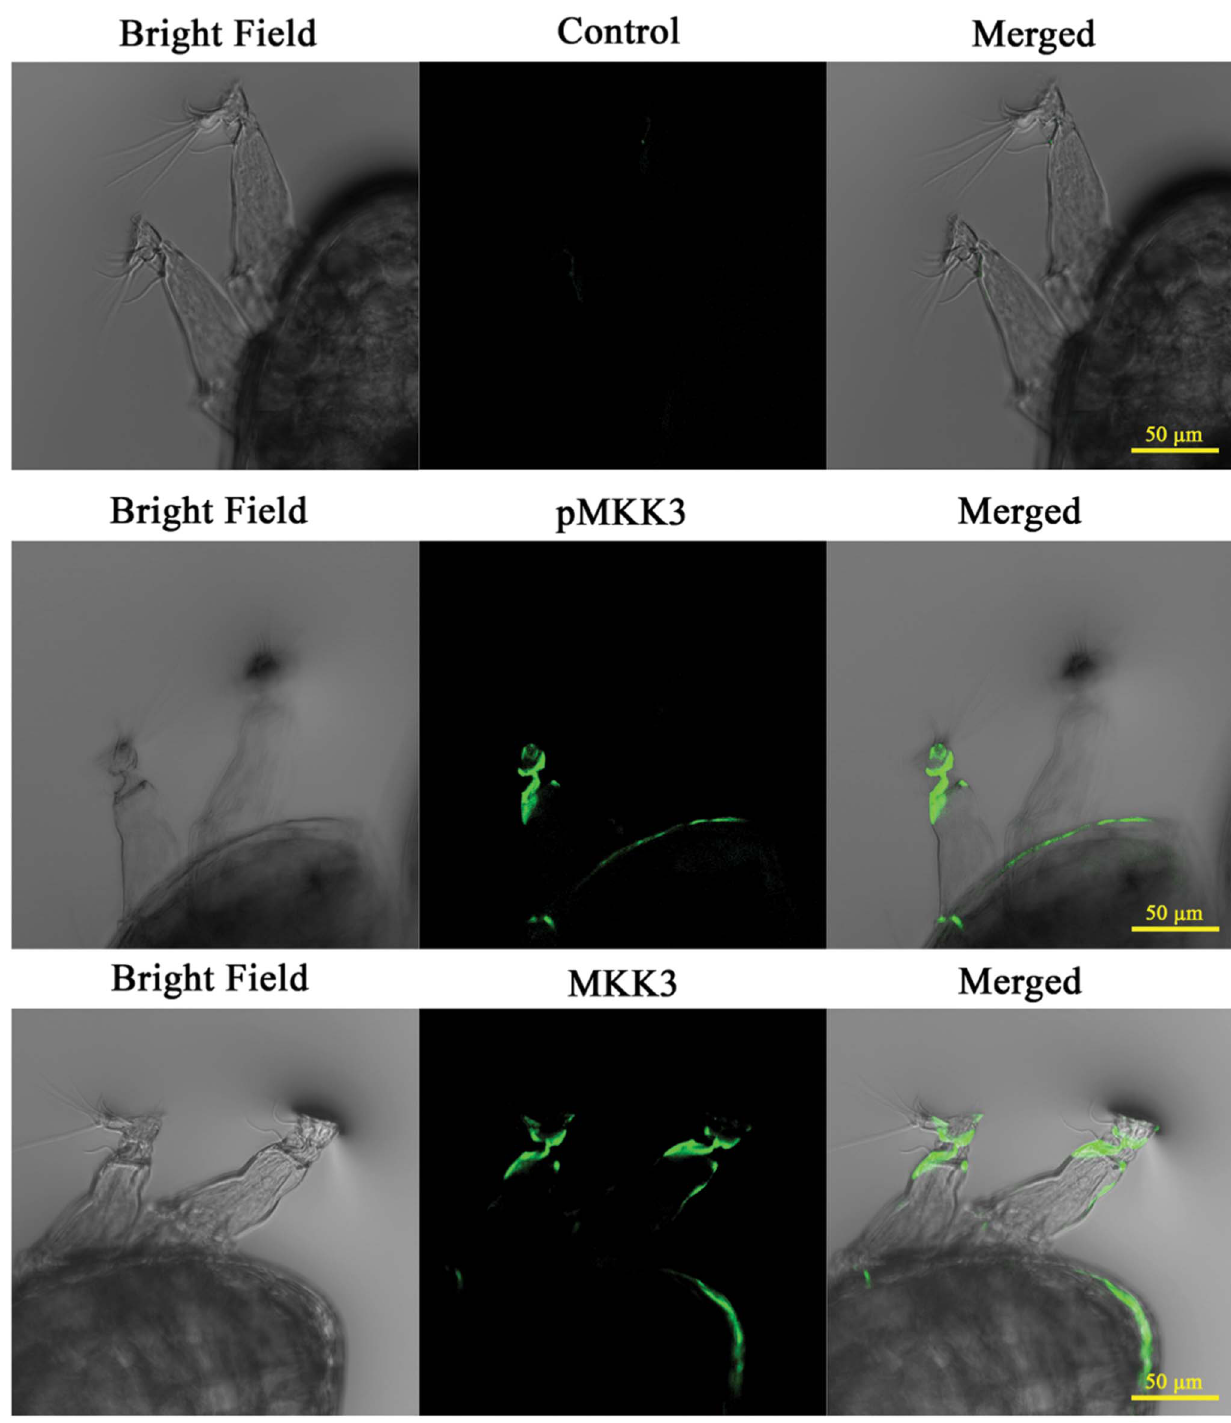
Figure 5. MKK3 and pMKK3 mainly localized to the antennules of barnacle cyprids. Cyprids were stained with MKK3 and pMKK3 antibodies. Larvae stained with secondary antibody alone were used as control. Images were obtained using a laser scanning confocal microscope with a 20X objective. Both MKK3 and pMKK3 were mainly concentrated at the third segment and the attachment organ of antennules.